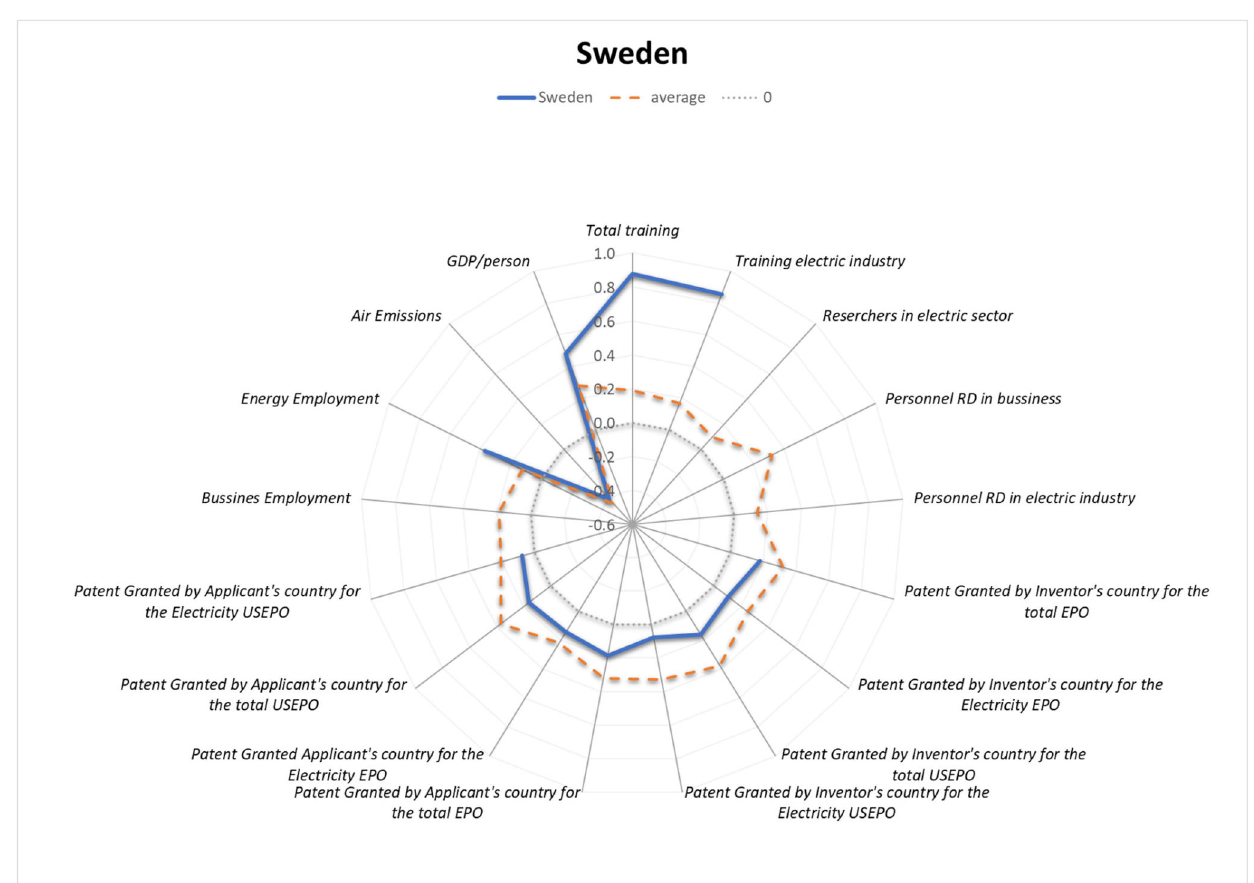
Figure 35. Synergy and trade-off occurrence—SE. Source: Authors’